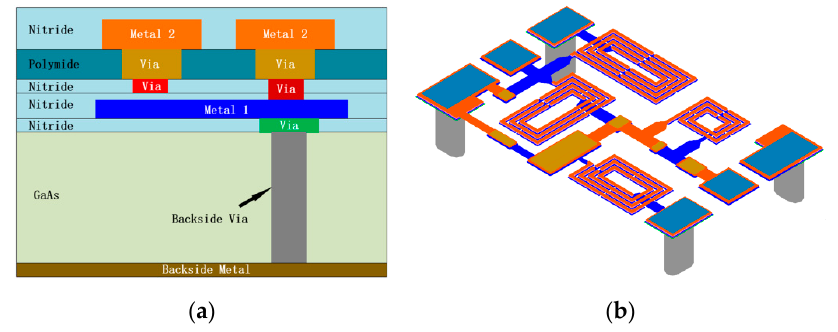
Figure 3. ( a ) Simplified layer structure of GaAs pHEMT without active transistor ( b ) 3D structure of the proposed UWB chip filter.